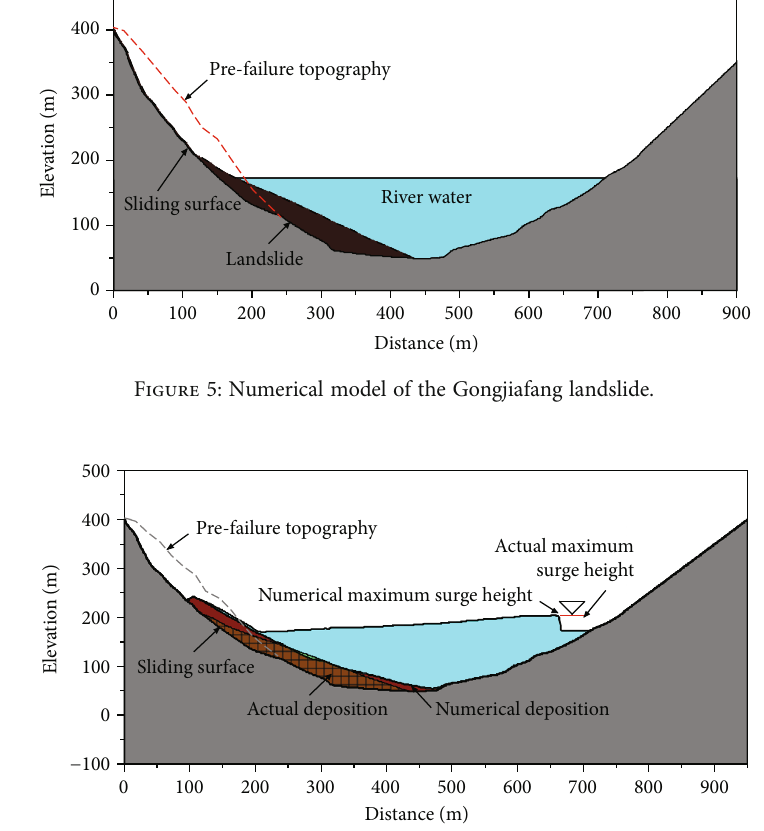
Figure 6: Comparison of numerical results and